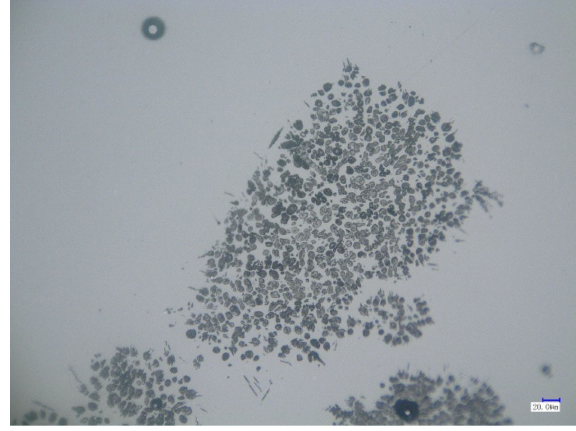
Figure 13. Optical microscopy analysis of C 2 S. Table 5. Element analysis of four points in Figure